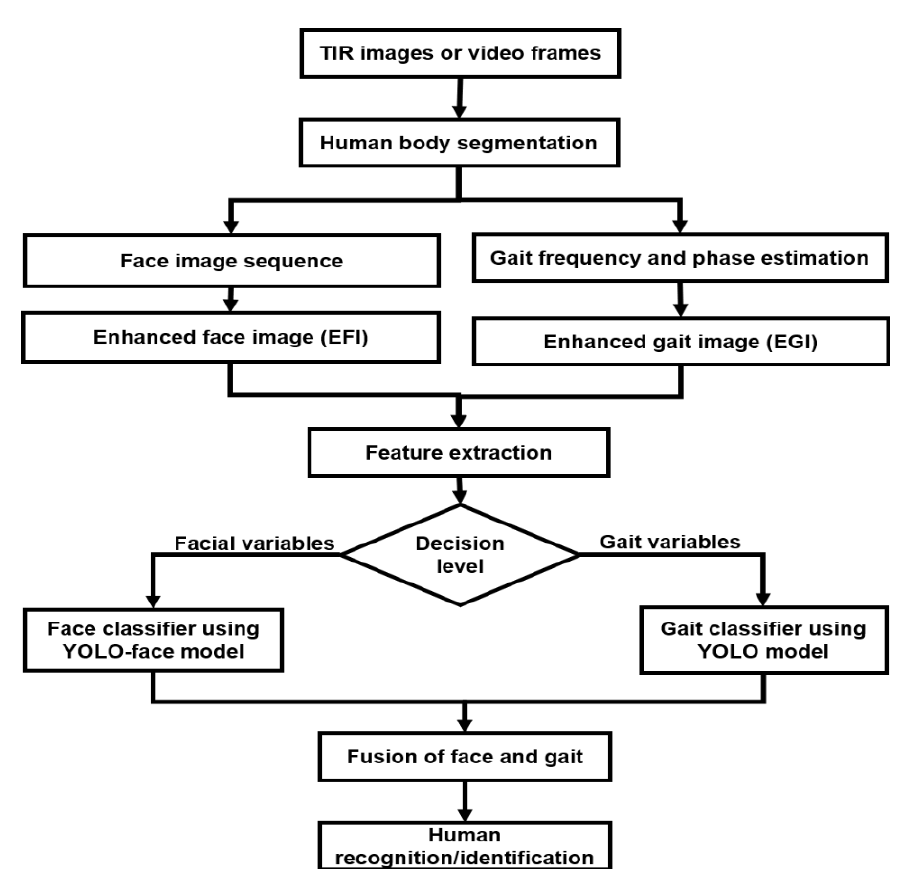
Figure 3. The overall tasks of multimodal (integrated face and gait classifiers) learning.